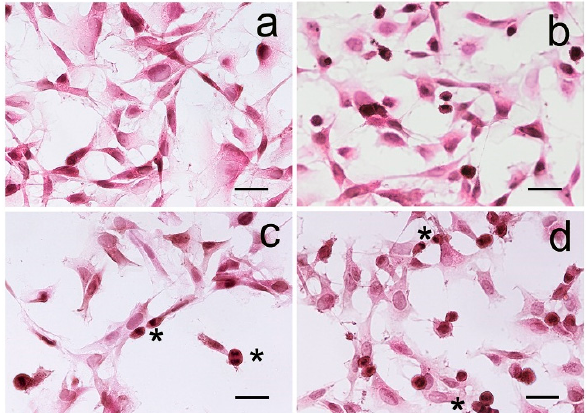
Figure 5. B104 cells treated with cyanobacteria aqueous cell supernatants. ( a ) control; ( b ) B104 cells after treatment with Halomicronema cf. metazoicum ITAC104; ( c ) B104 cells after treatment with Synechococcus sp. ITAC107; ( d ) B104 cells after treatment with the undetermined Oscillatoriales ITAC105. Asterisks indicate dividing cells. Scale bar = 20 μ m.